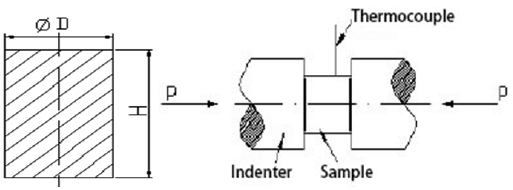
Figure 1. Schematic diagram of compression tests.